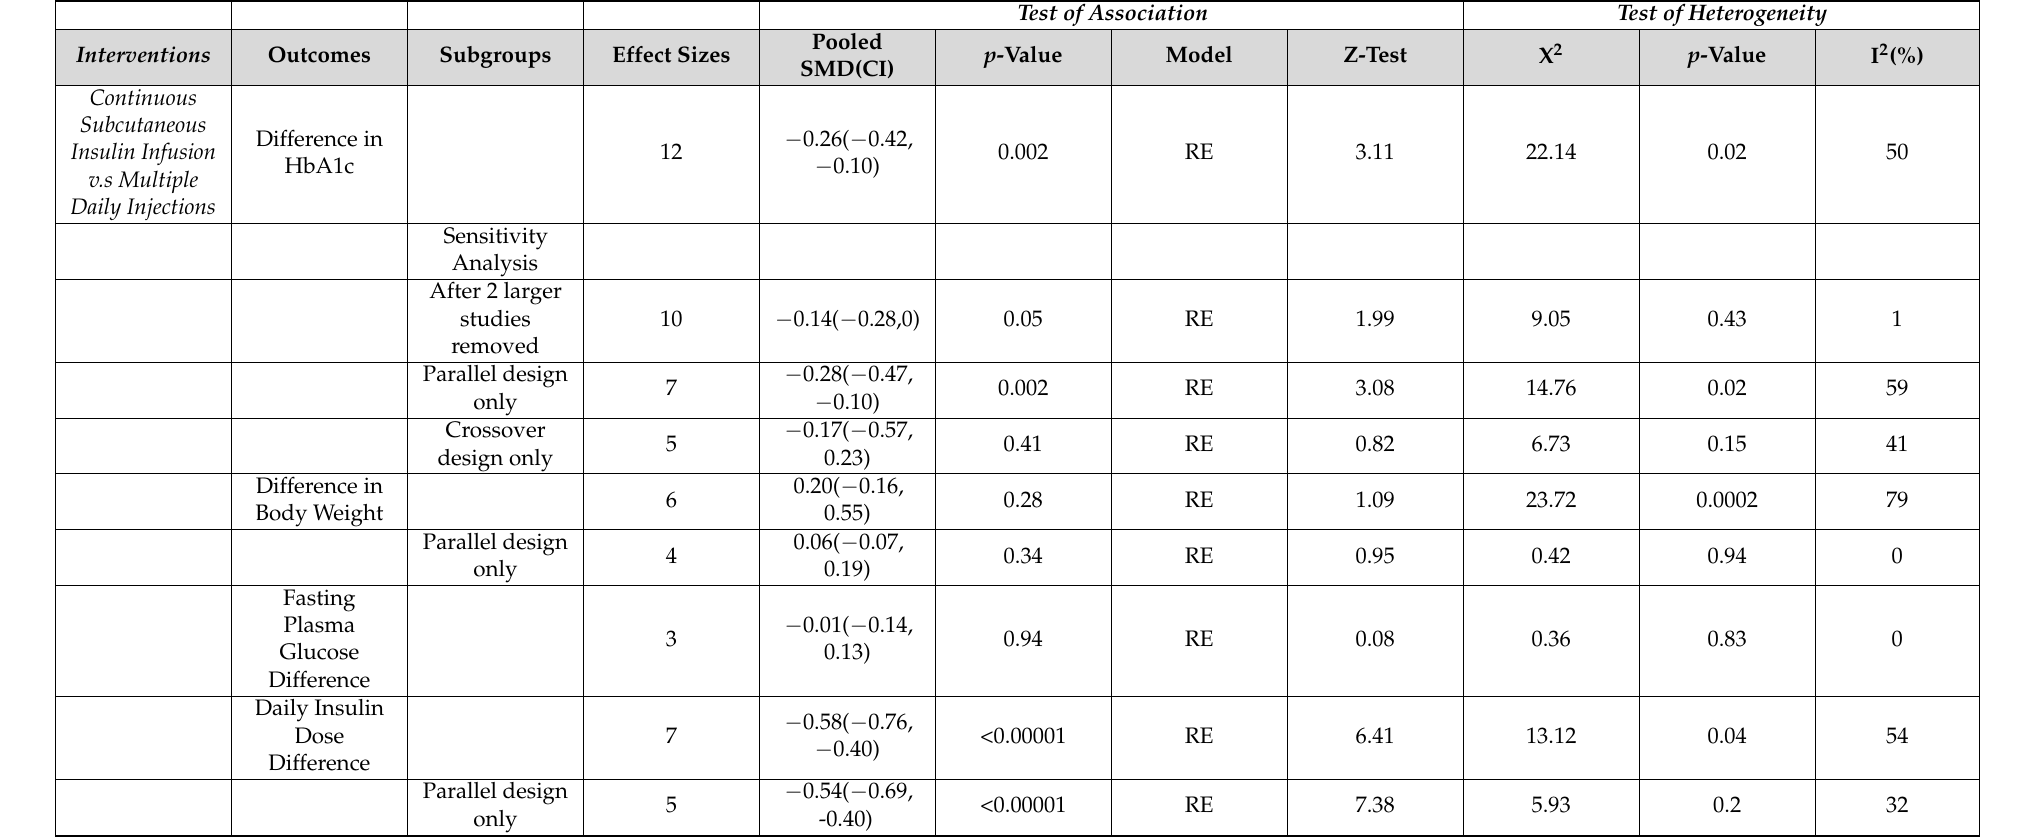
Table 4. Pooled results of meta-analysis and sensitivity analysis for each outcome. Test of Association Test of